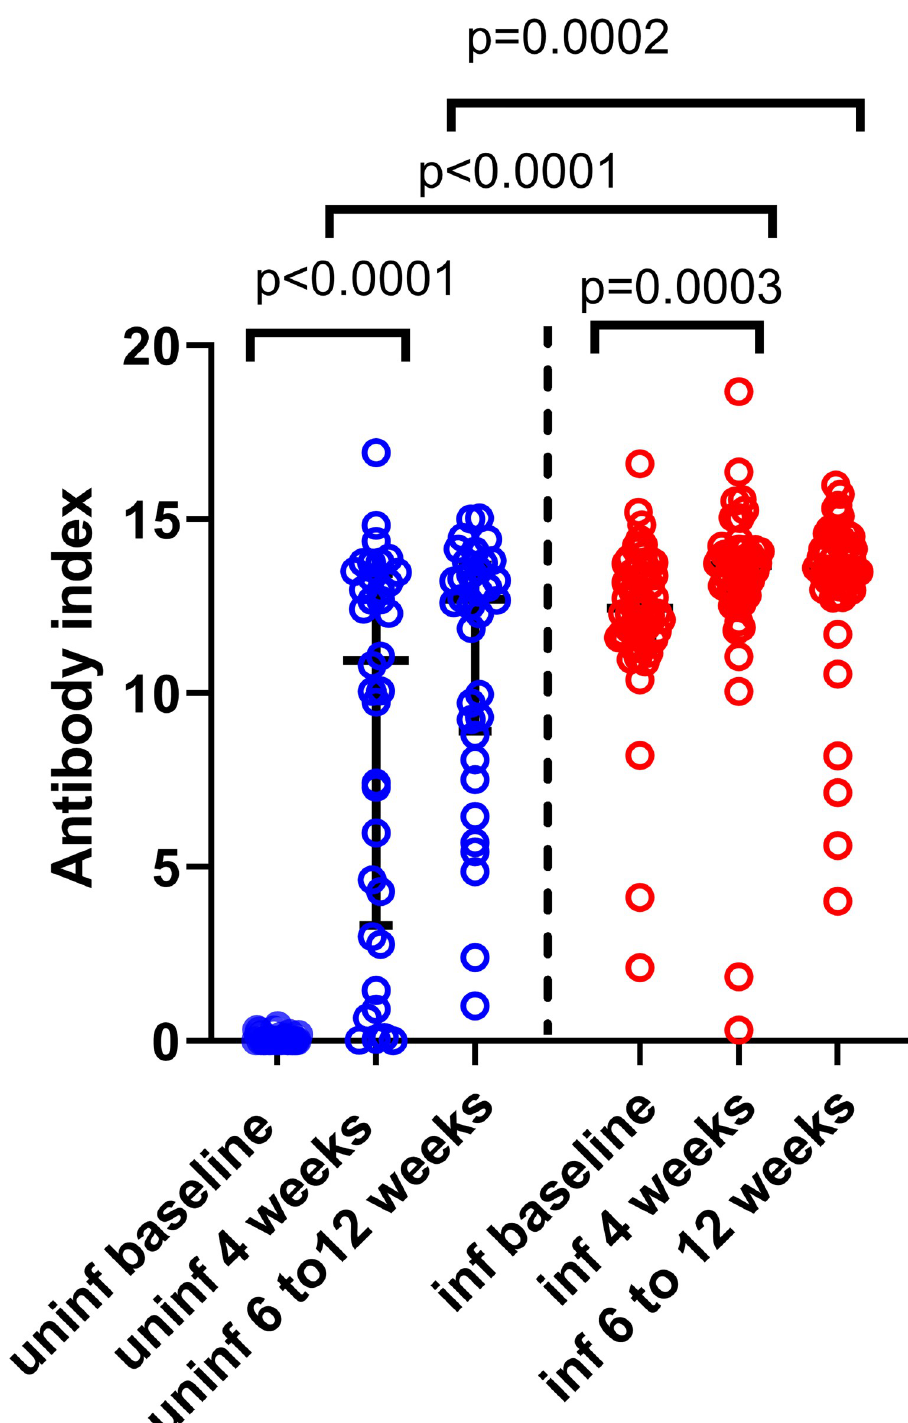
Fig 1. Antibody responses to the receptor binding domain of SARS-CoV-2 virus, following first and second dose of the Sinopharm/ BBIBP-CorV vaccine. SARS-CoV-2 specific total antibodies were measured in baseline uninfected (n = 36) and infected (n = 58) pregnant women by ELISA, at baseline, 4 weeks from the first dose and 6 to 12 weeks following the second dose (2 to 8 weeks following the second dose). Wilcoxon matched-pairs signed rank test was used to compare the means of the antibody indexes, before and after the vaccine, while the Mann-Whitney U test was used to calculate the differences in antibody responses at each time point in baseline infected and uninfected women. All tests were two-tailed. The lines indicate the median and the inter quartile